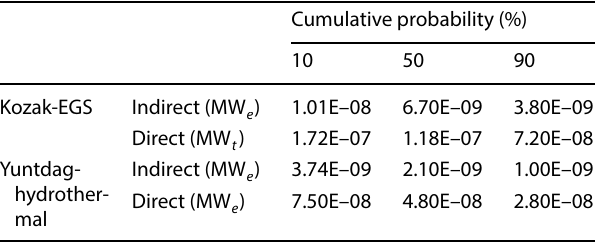
Table 3 Power output of each case in with 10%, 50% and 90% probability, respectively (for unit volume of reservoirs)